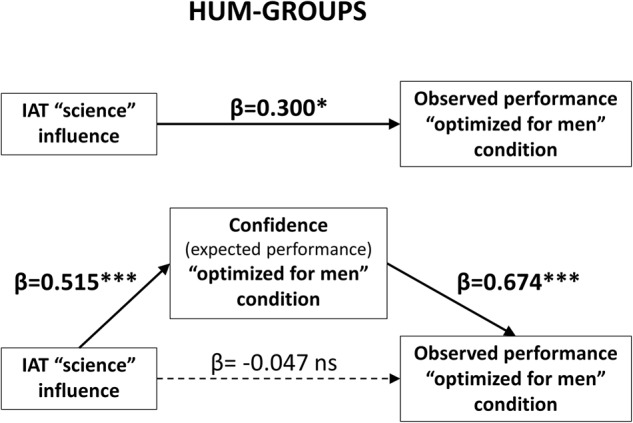
Expected performance (confidence) mediates the effects of implicit gender-science associations. Mediation analysis was performed according to the 3-steps regression method described by Baron and Kenny (1986). First, we confirmed that the IAT “influence” scores predicted 3DMRT observed performance (β = 0.300, p < 0.05). Then we confirmed that these scores also predicted confidence (expected performance; β = 0.515, p < 0.000) and that confidence predicted observed performance (β = 0.650, p < 0.000). Finally, we simultaneously included the IAT “influence” and confidence scores as predictor variables of 3DMRT observed performance in a single regression equation. In this crucial step, only the confidence (expected performance) scores remained as strong predictors (β = 0.674, p < 0.000) of observed performance, while the predictive value of IAT “influence” scores became almost zero (β = –0.047, p = 0.727), hence revealing a near complete mediatory effect of confidence (∗p < 0.05, ∗∗∗p < 0.000; ns, non-significant).